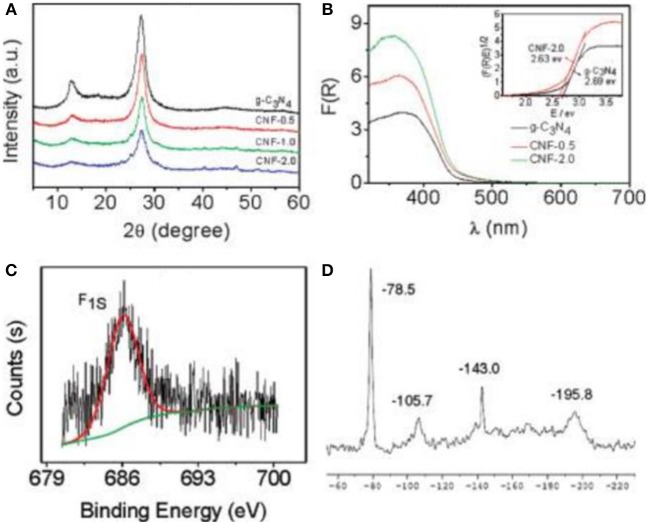
(A) XRD patterns of samples. (B) UV-Vis spectra of g-C3N4 and CNF-x (inset shows optical band gaps(E)g of g-C3N4 and sample-2.0). (C) XPS spectrum of sample-2.0. (D) Solid-state MAS-NMR spectrum of sample-2.0 (Wang et al., 2010). Copyright 2010, American Chemical Society.